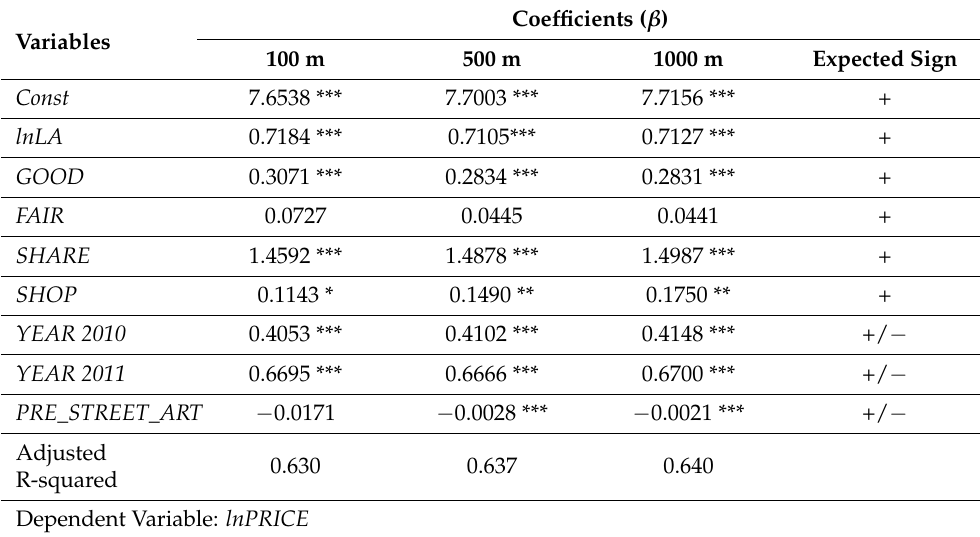
Table 6. OLS Regression Results of Model